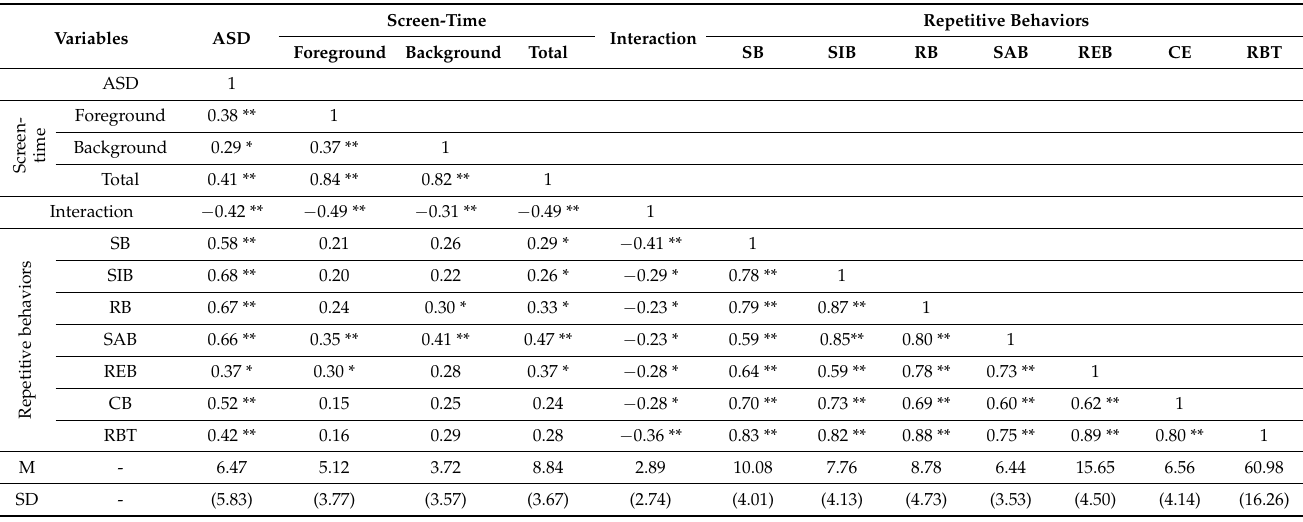
Table 2. Overview of correlational computations (Pearson’s correlations) between toddlers’ symptoms of ASD and screen time ( n = 68).